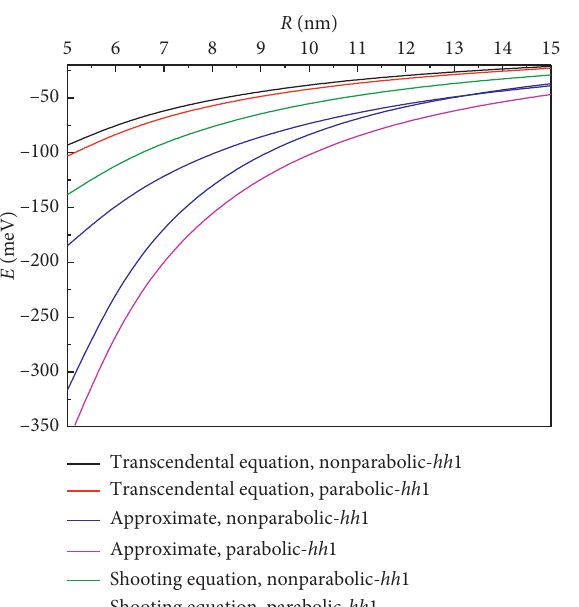
Figure 4: The dependence of the energy of a light hole on the radius of a cylindrical quantum wire for the parabolic and nonparabolic dispersion